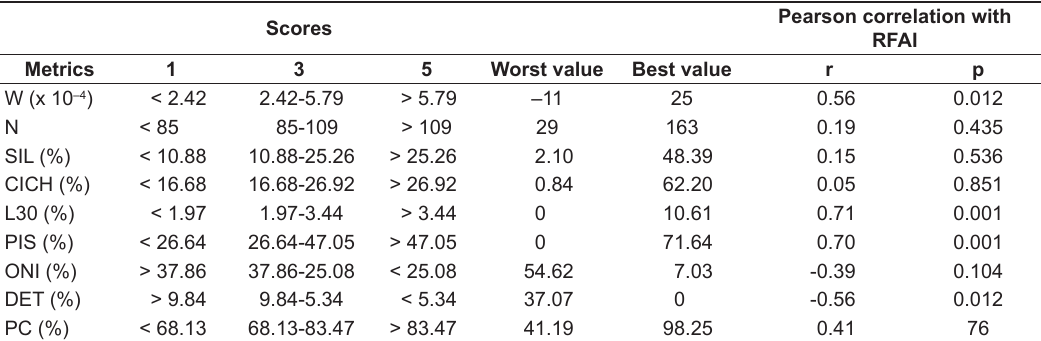
Table 3. Observed intervals and limits used to score the metrics. See Table 1 for metrics that correspond to abbreviations.